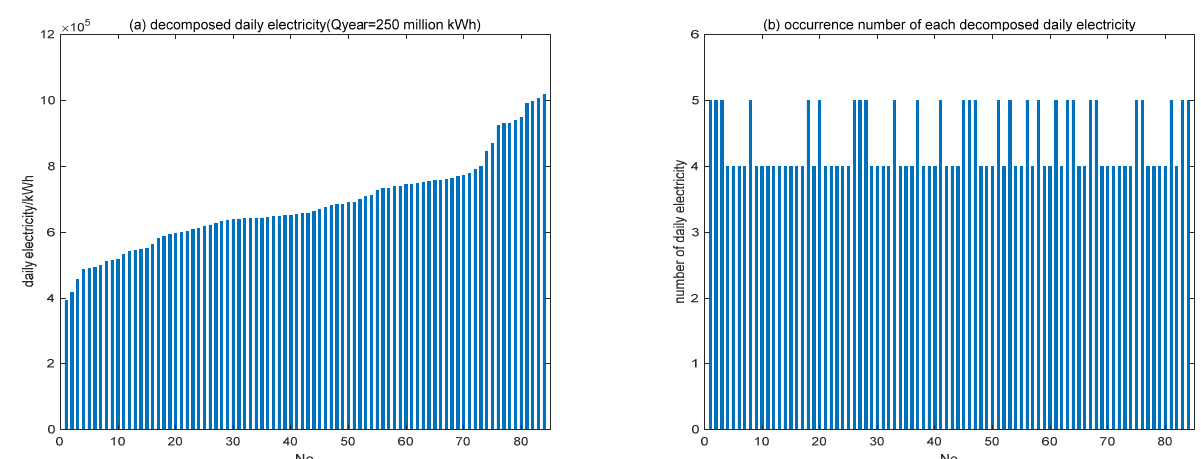
Figure 14. Daily electricity types and the occurrence numbers of different types .